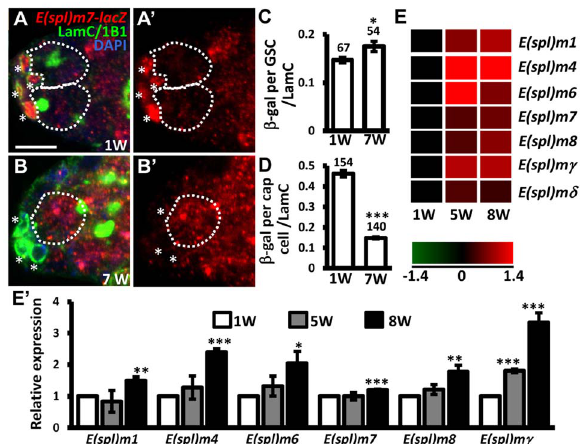
Fig. 5. Notch signaling is increased in GSCs with age. (A and B) One-week (w)-old and 7-w-old germaria with ß-gal (red, E(spl)m7-lacZ , a N reporter), 1B1 (green, GSC fusomes), LamC (green, cap cell nuclear envelopes), and DAPI (blue) labels. A 9 and B 9 show the E(spl)m7-lacZ channel only. GSCs are outlined by dashed circles. Asterisks indicate cap cells. ( C and D ) Ratio of ß-gal expression in GSCs (C) and cap cells (D) to average LamC expression in cap cells (internal control) in 1 and 7-w-old germaria. The number of cells analyzed is shown above each bar. **, P , 0.01; ***, P , 0.001. Error bar, mean 6 SEM. (E) Heat map of E(spl) genes that are up-regulated in GSCs with age ( P , 0.05). The colors represent the log 2 values: red - up-regulation; green - down-regulation; black - no change. The gene names are indicated at the right of each row. Each column represents the data from the indicated time point. (E 9 ) Expression levels of the indicated genes in GSCs isolated from 1-week (w), 5w, and 7w-old germaria, as determined using RT-qPCR. Data were normalized to the stable endogenous control gene, rpL32 . [Data normalized to rpL19 revealed the same trend at 5w]. Normalized data were subjected to Student’s t -test. *, P , 0.05; **, P , 0.01; ***, P , 0.001. The genotype of the flies in A–D is + ; + ; E(spl)m7-lacZ *, P , 0.05; **, P , 0.001. Error bar, mean 6